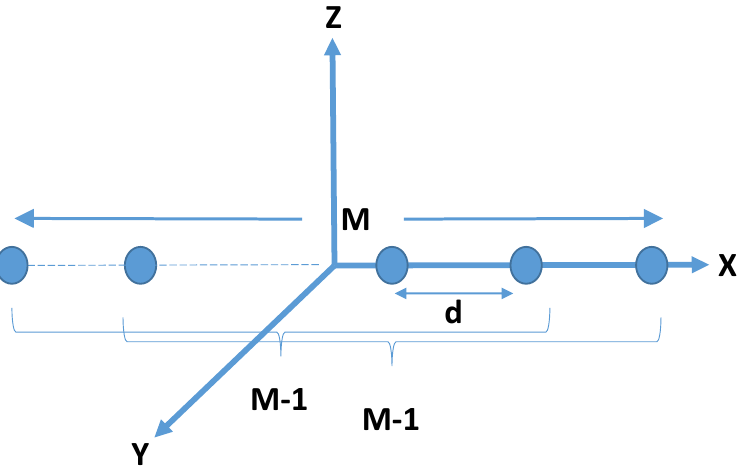
Figure 12. ESPRIT Sub-Arrays, M element array with two ( M -1 )